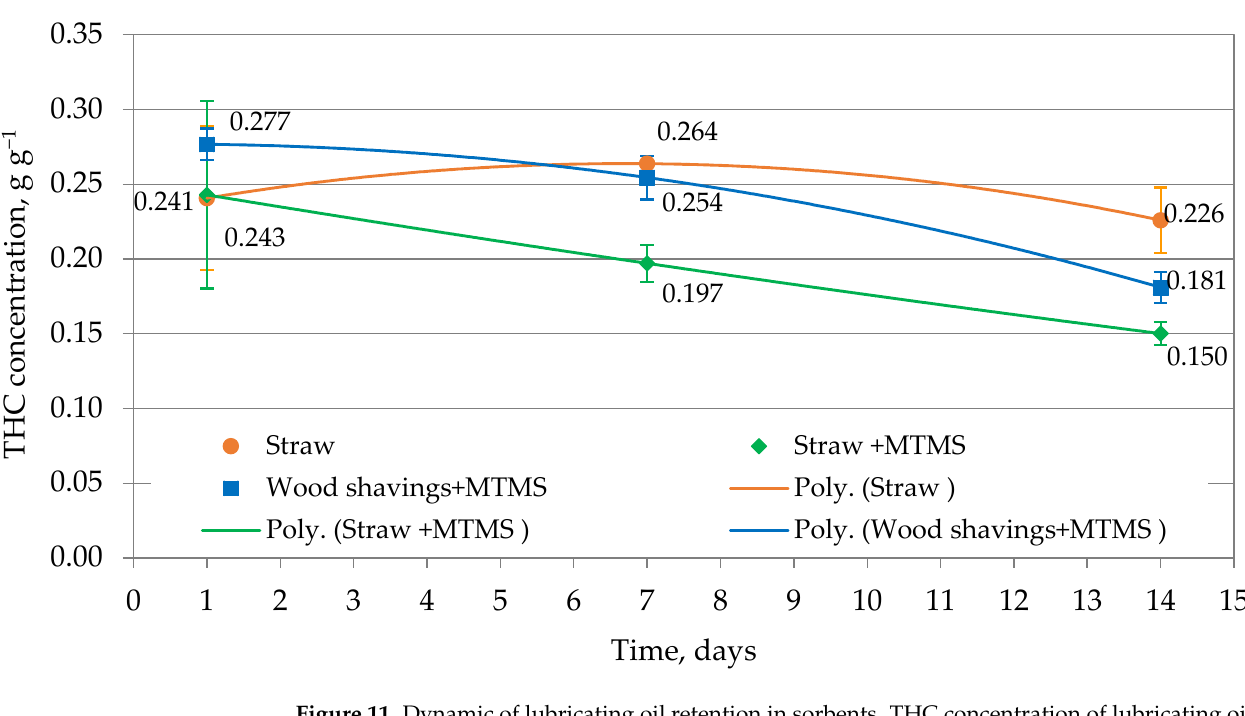
Figure 11. Dynamic of lubricating oil retention in sorbents. THC concentration of lubricating oil in the sorbent straw with and without MTMS treatment and MTMS-treated wood shavings after 1, 7 and 14 days.